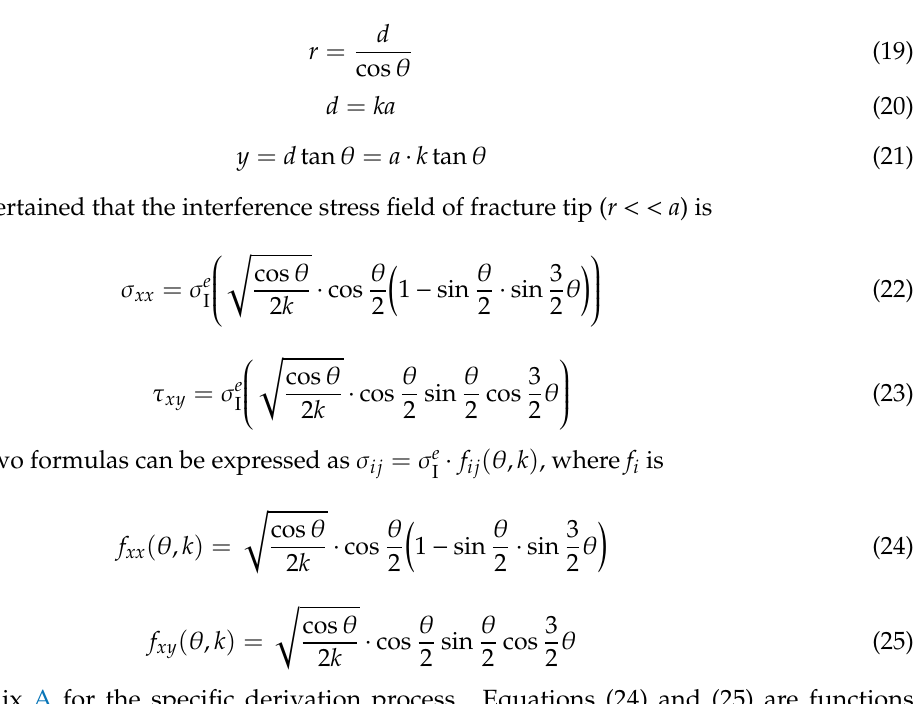
Figure 8. Polar coordinate system of fracture front of orthogonal joint.